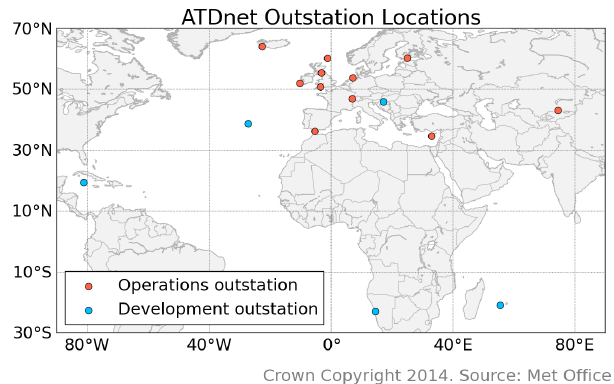
Fig. 1. The locations of ATDnet sensors that contribute to the oper- ations network (red dots), and development outstations (blue dots).